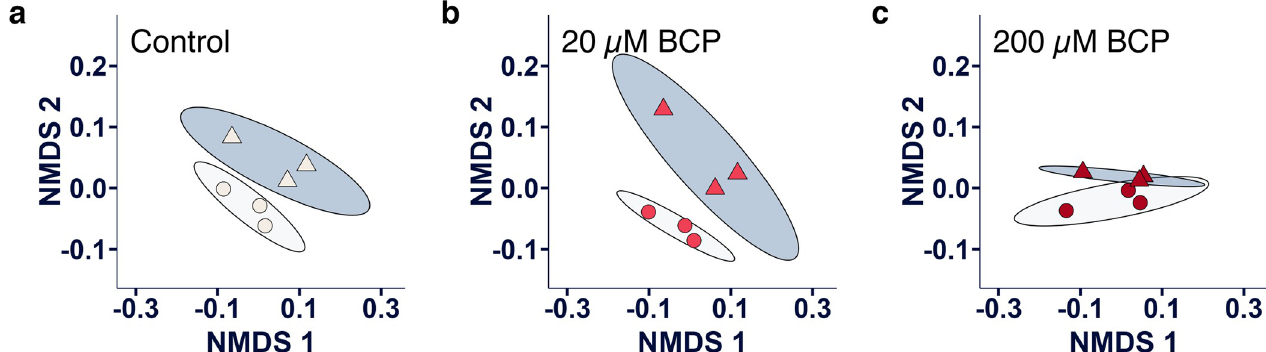
Fig 5. BCP attenuates the effect of the lipidomic signature of hypoxia. UFH-001 cells were exposed to normoxic or hypoxic conditions in the presence of BCP for 16h. At the end of the incubation, cells were washed and processed for lipid extraction as described in Methods. NMDS was performed on 25 analytes using MetaMDS with Bray-Curtis dissimilarities. The distances between points reflects their relative similarity to or difference from each other. Circular points represent cells in normoxic conditions; triangular points represent cells in hypoxic conditions. Light-shaded ellipse regions are the 95% confidence areas for the normoxic samples; darker-shaded ellipse regions are the 95% confidence areas for the hypoxic samples. (a) Control conditions without BCP, (b) 20 μ M BCP, (c) 200 μ M BCP.